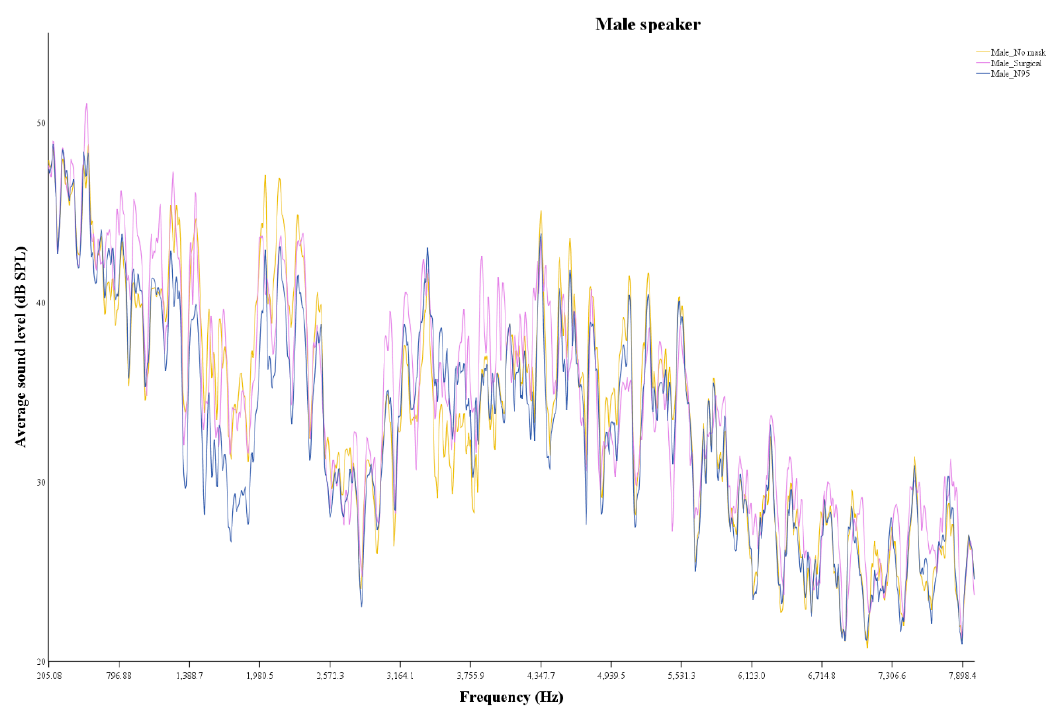
Figure 3. Average sound pressure level for male speaker.